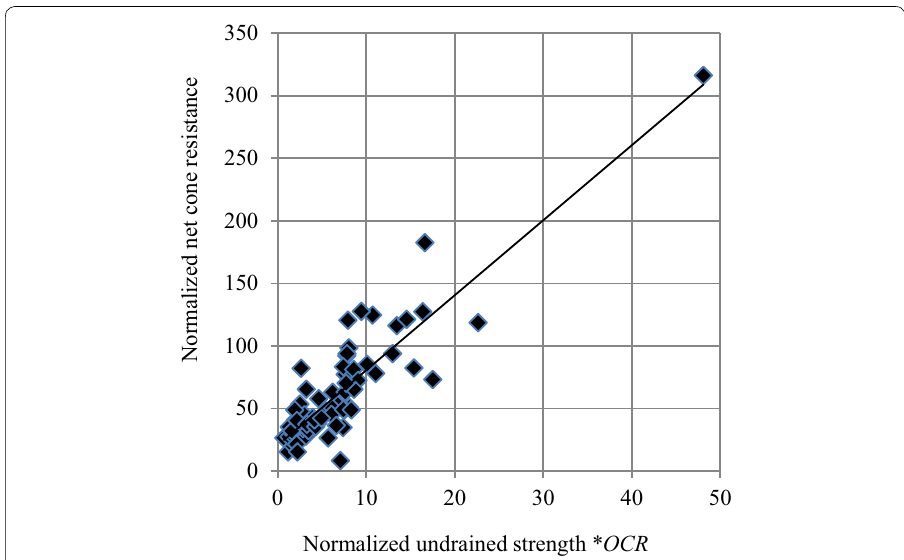
Fig. 5 Relationship of normalized net cone resistance and undrained strength for clay